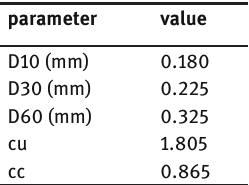
Table 2: X-ray fluorescence of the Biskra Silica Dune Sand.